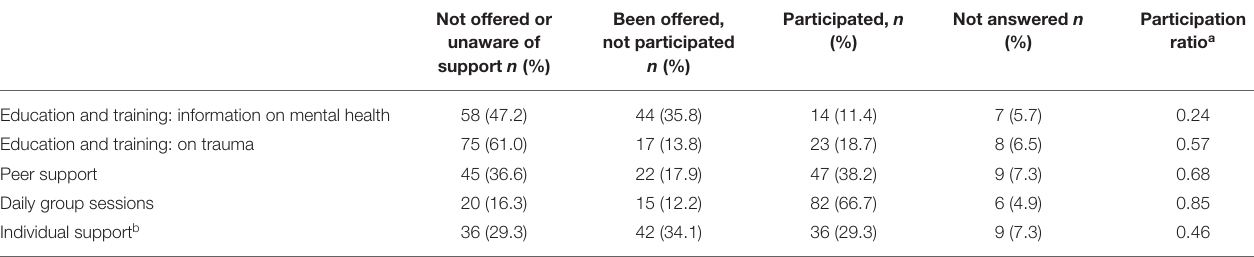
TABLE 1 | Frequency of participation in different support efforts.